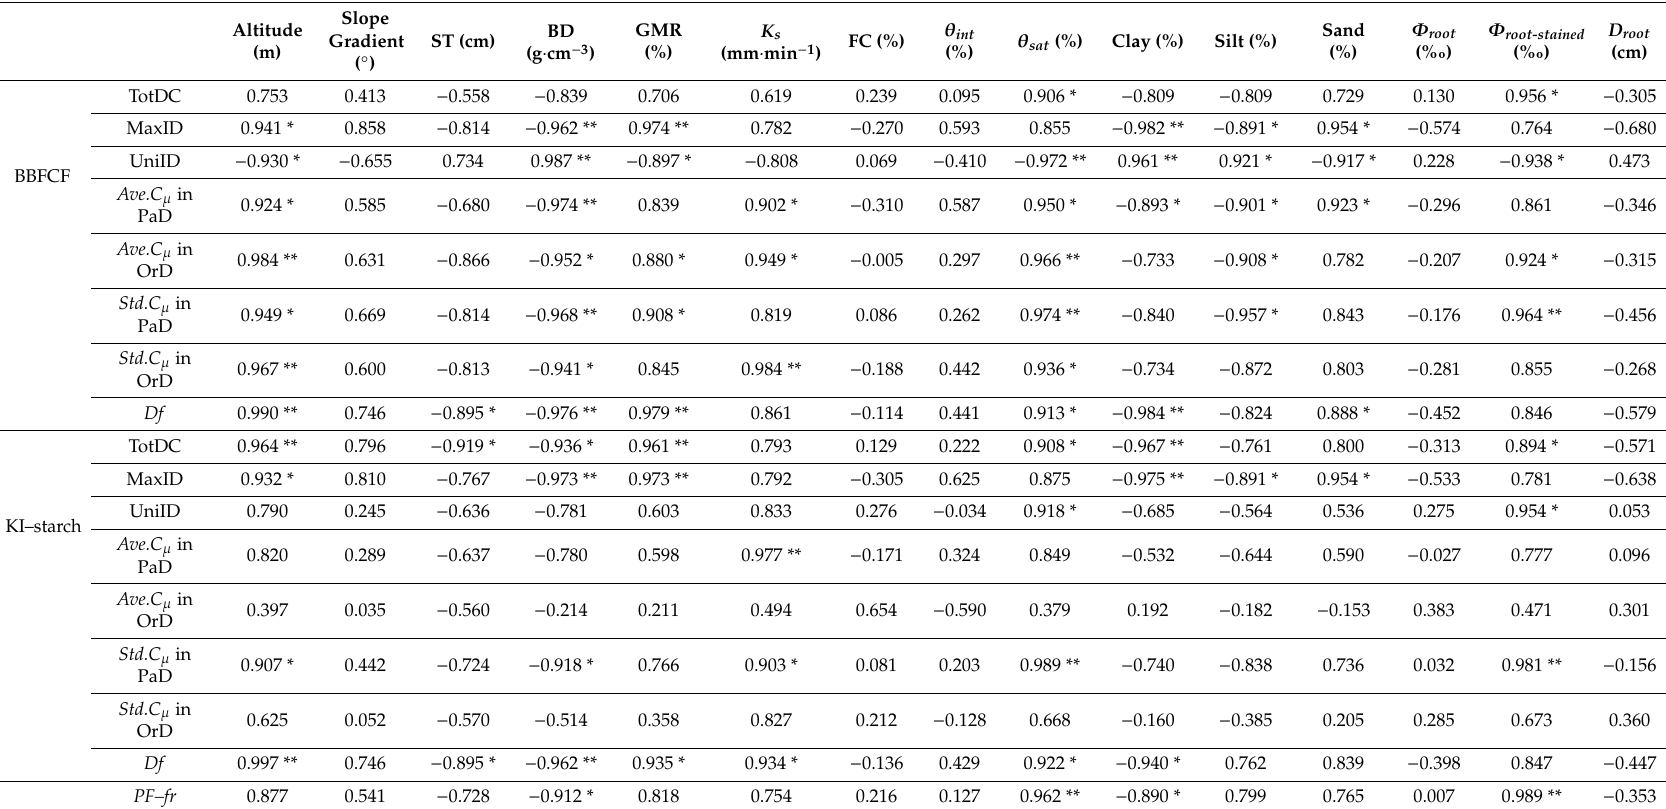
Table 5. Correlation coe ffi cients of preferential flow and environmental